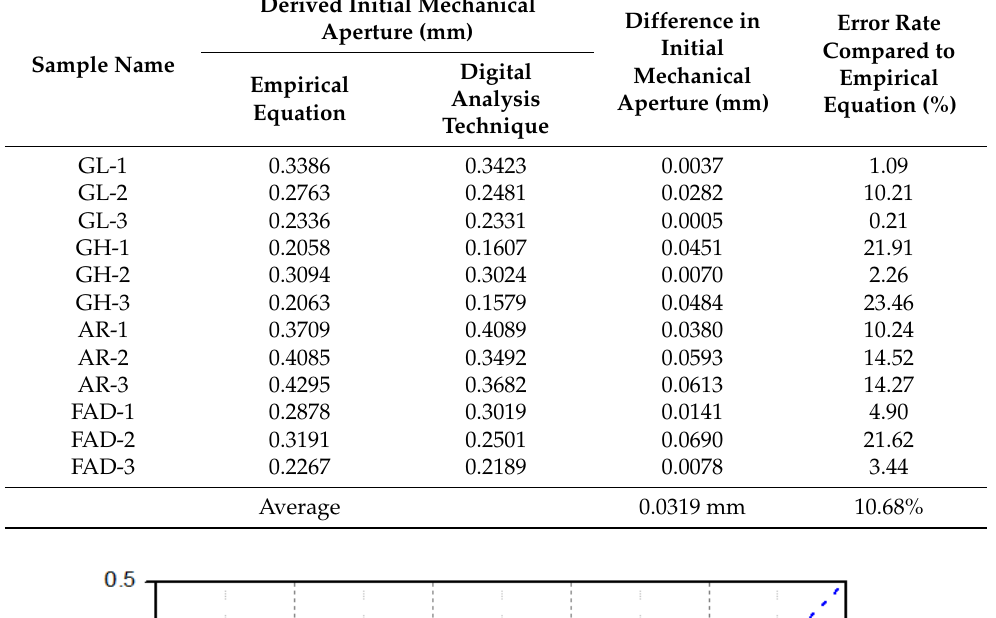
Table 4. Initial mechanical apertures derived using the empirical equation and digital analysis technique.